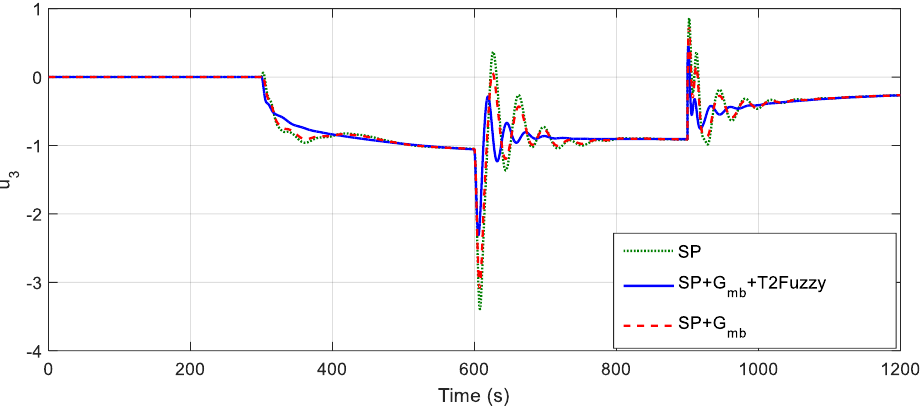
Figure 24. The control signal 𝑢 3 for all three methods.